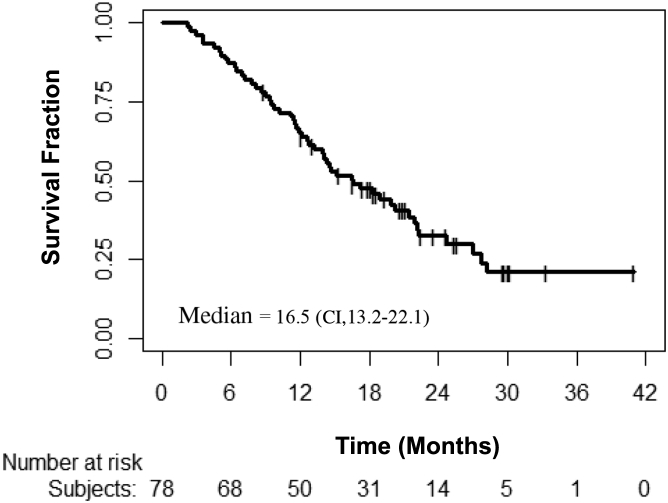
Kaplan–Meier Curve for Overall Survival of the Entire Patient Population